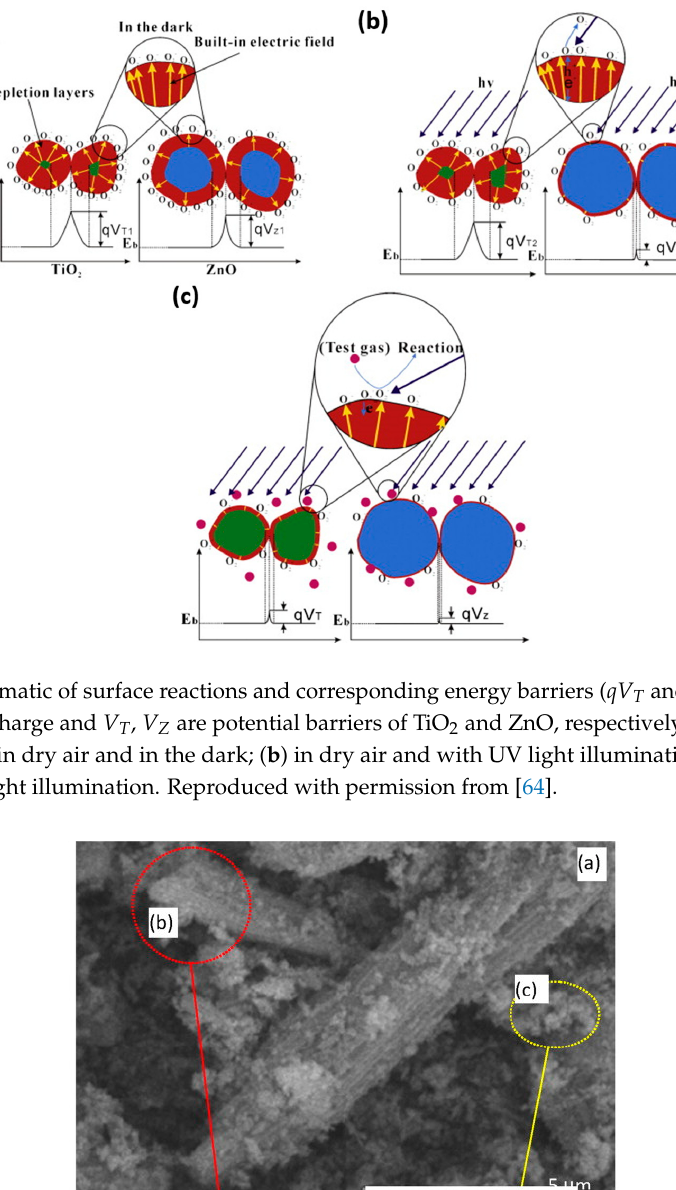
Figure 34. Current transients of TiO 2 and ZnO after exposure to 75 ppm of formaldehyde gas. Reproduced with permission from [64].